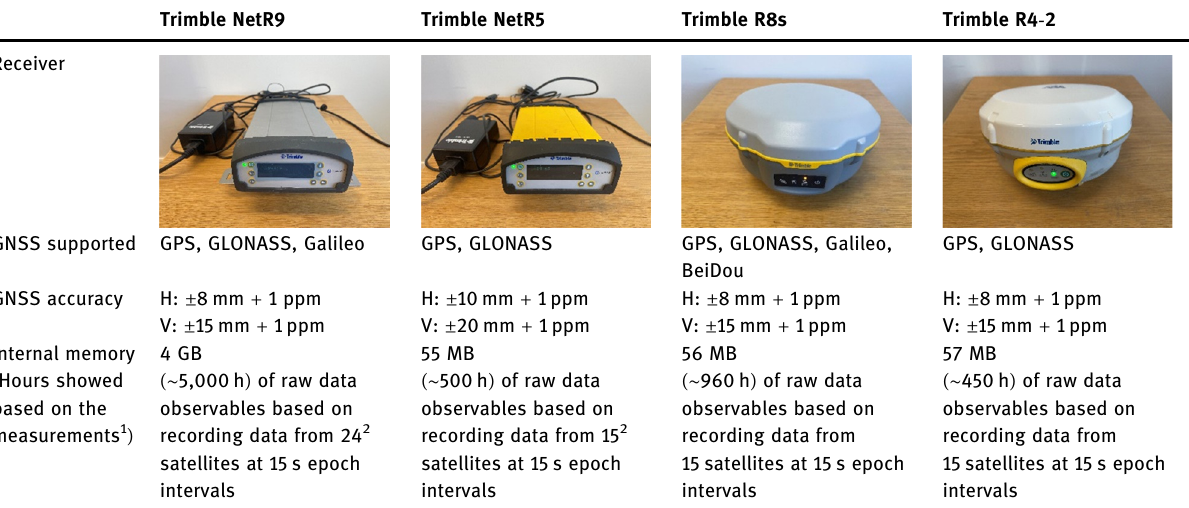
Table 4: Technical parameters of the used instruments Trimble NetR9 Receiver